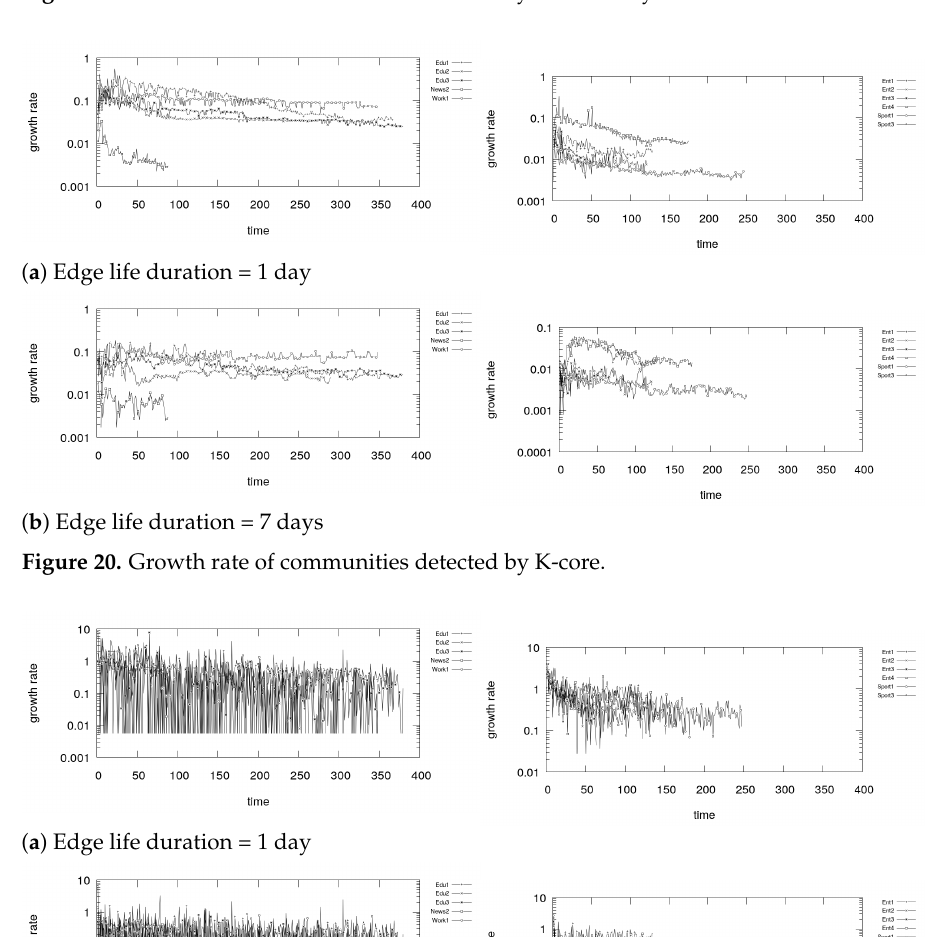
Figure 19. Growth rate of communities detected by Fast Greedy.